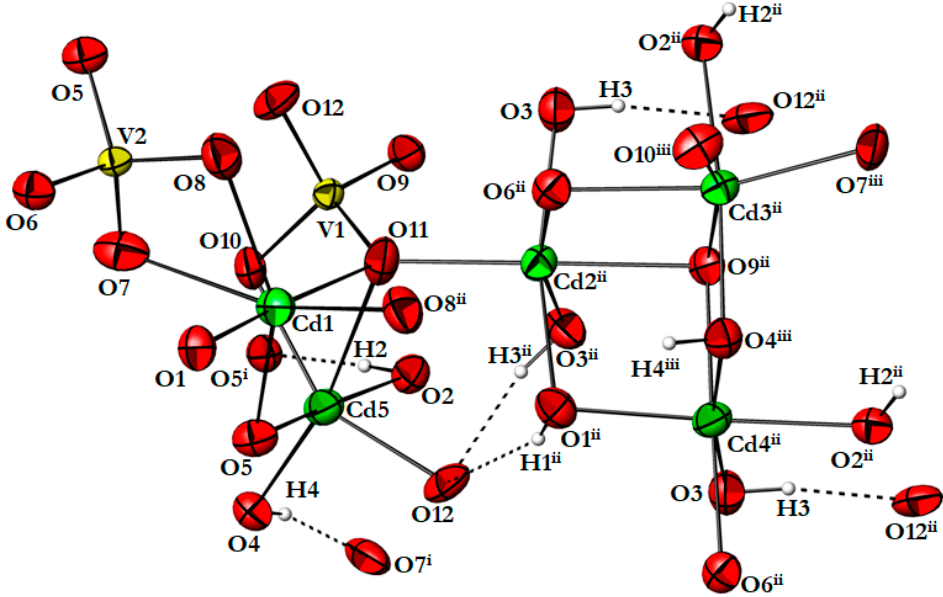
Figure 1. The structural fragment showing ellipsoids of ADP (90% probability), hydrogen bonds, and atomic labeling scheme. Symmetry codes: (i) − x + 1/2, − y , z + 1/2; (ii) − x , y + 1/2, − z + 1/2; (iii) x + 1/2, − y + 1/2, − z .